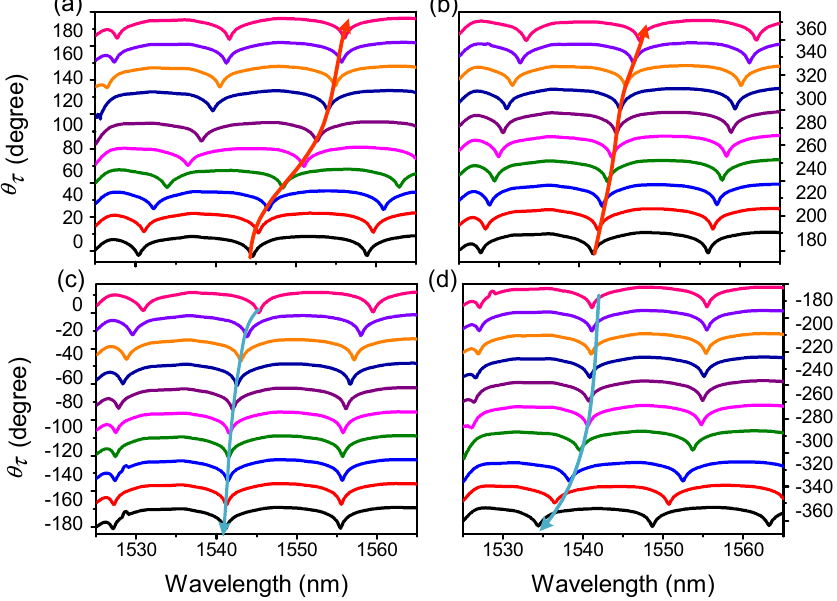
Figure 3. Spectra evolution of PMF-SI in the clockwise (CW) direction from ( a ) 0 ◦ to 180 ◦ and ( b ) 180 ◦ to 360 ◦ and the anticlockwise (ACW) direction from ( c ) 0 ◦ to − 180 ◦ and ( d ) − 180 ◦ to − 360 ◦ . For clarity, the sensitive and insensitive regions in Figure 4a,b were divided into four